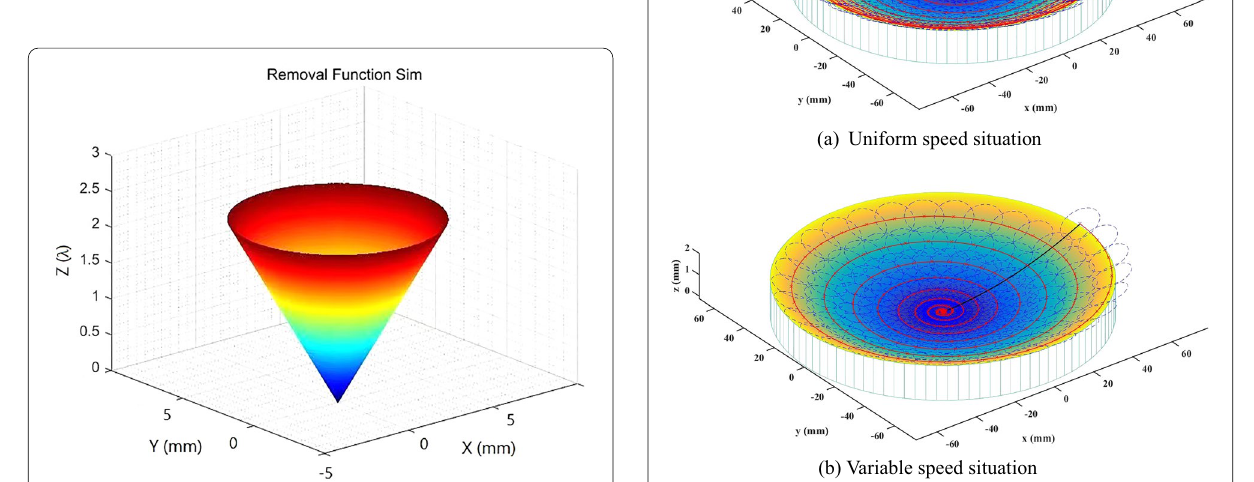
Figure 10 Removal function Figure 11 Schematic diagram of polishing